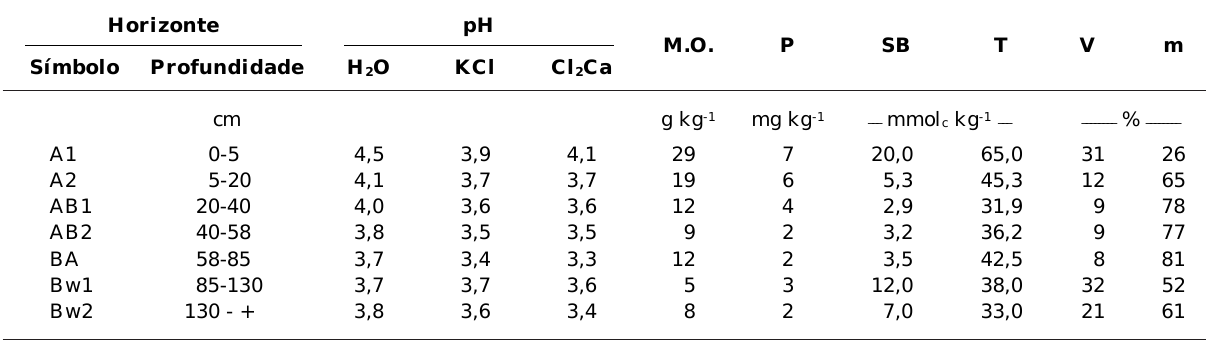
figura 2, são apresentados os valores de t quando da comparação das médias dos valores de resistência à penetração (horizonte coeso menos não-coeso), sob condições de solo úmido e seco.